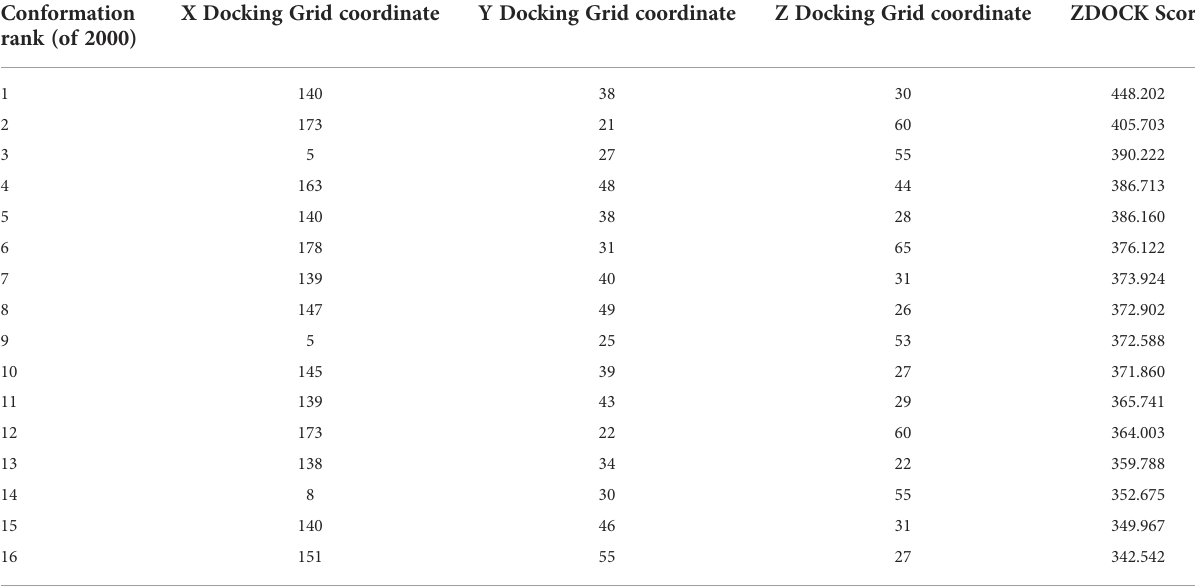
TABLE 1 Top 16 ZDOCK scores, representing the electrostatic and geometric fi t between protein residues, out of 2000 potential conformations between SP-A and SARS-CoV-2 Spike.